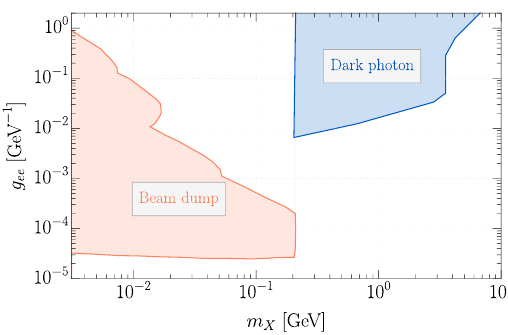
Figure 5 . Constraints on g ee as a function of m X , reproduced from ref. [21]. Note that the BaBar dark photon bound is valid for universal diagonal couplings g ee = g µµ = g ττ